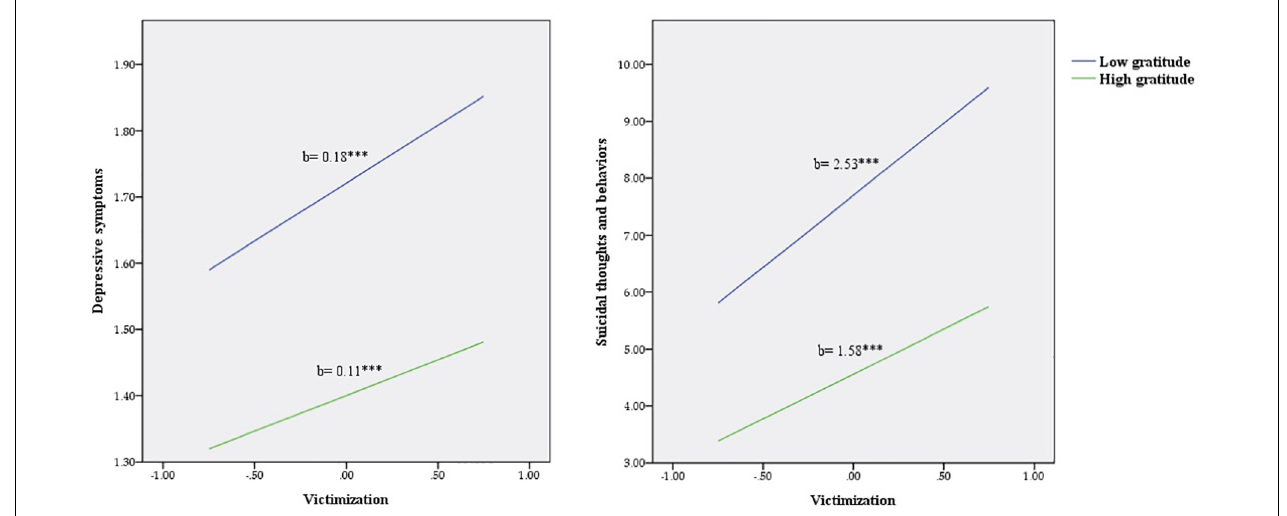
FIGURE 1 | Relationship of victimization and gratitude for predicting suicide risk (depressive symptoms and suicidal thoughts and behaviors) in girls. ∗∗∗ p < 0.001.